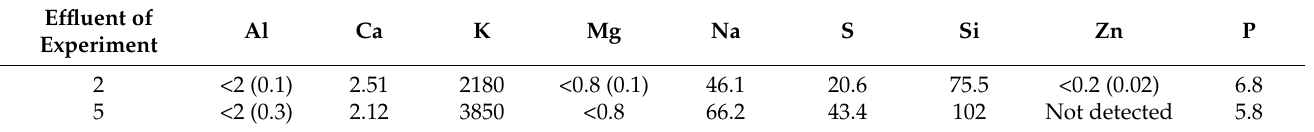
Table 5. Elemental composition of effluents of experiments with Reed Canary Grass (in µ g mL − 1 ). Effluent of